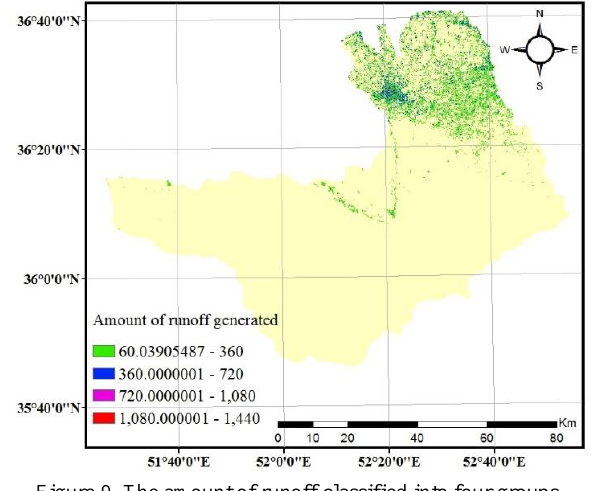
Figure 9. The amount of runoff classified into four